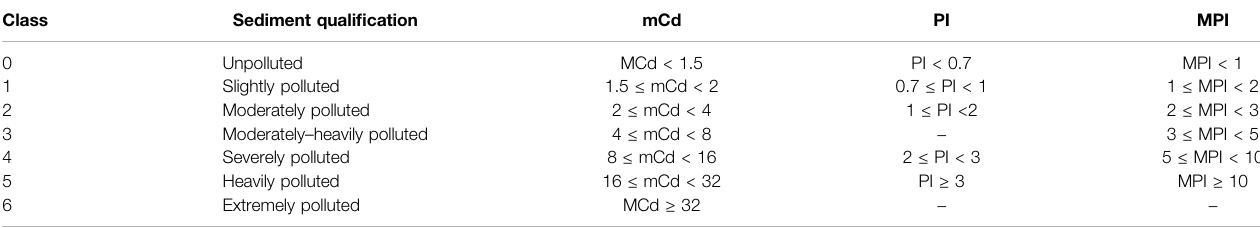
TABLE 1 | Thresholds for sediment quality classi fi cation for multi-element indices.